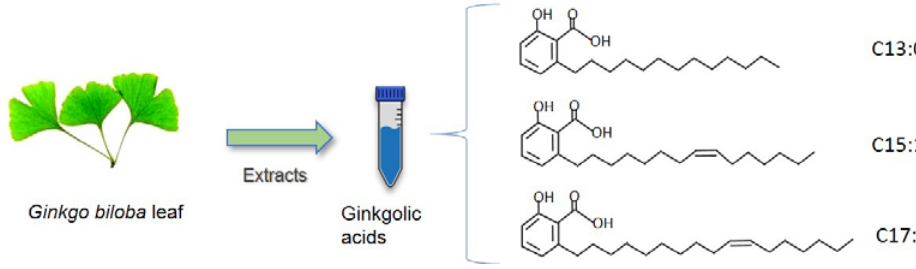
Figure 1. Chemical structures of major ginkgolic acids C13:0, C15:1, and C17:1.